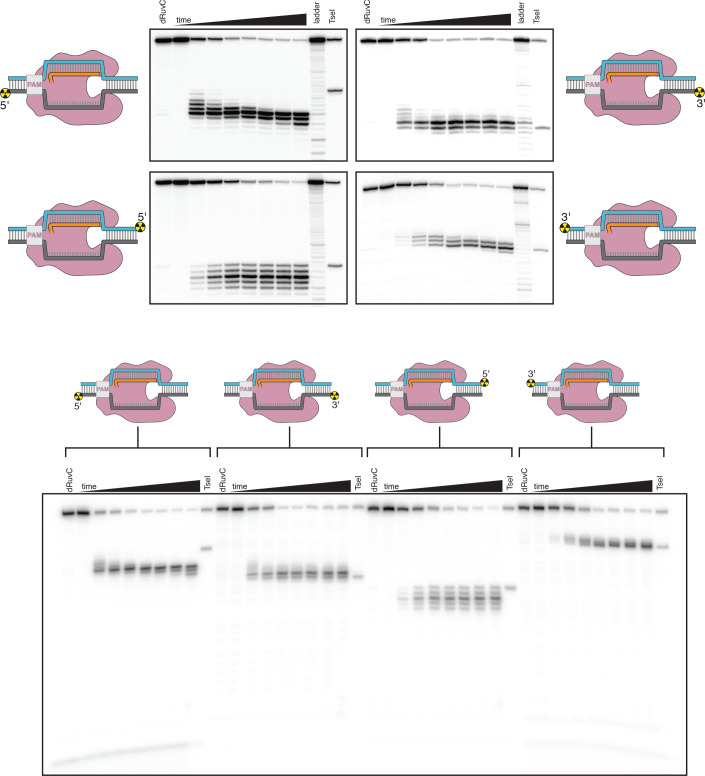
Denaturing PAGE analysis of AsCas12a cleavage products.Top panel: The leftmost lane in each gel is a 1-hr timepoint with AsCas12a D908A (mutation in the RuvC active site). The timepoints shown for the reactions with WT enzyme are 0 s, 5 s, 10 s, 20 s, 40 s, 80 s, 10 min, 1 hr. The ladder was made by digestion of the relevant substrate with a cocktail of non-specific DNases (see Materials and methods). The rightmost lane is the same probe cleaved by the site-specific restriction enzyme TseI. Bottom panel: The same products run on a gel for a shorter amount of time to demonstrate the absence of faster-migrating species. This gel lacks the ladder samples.